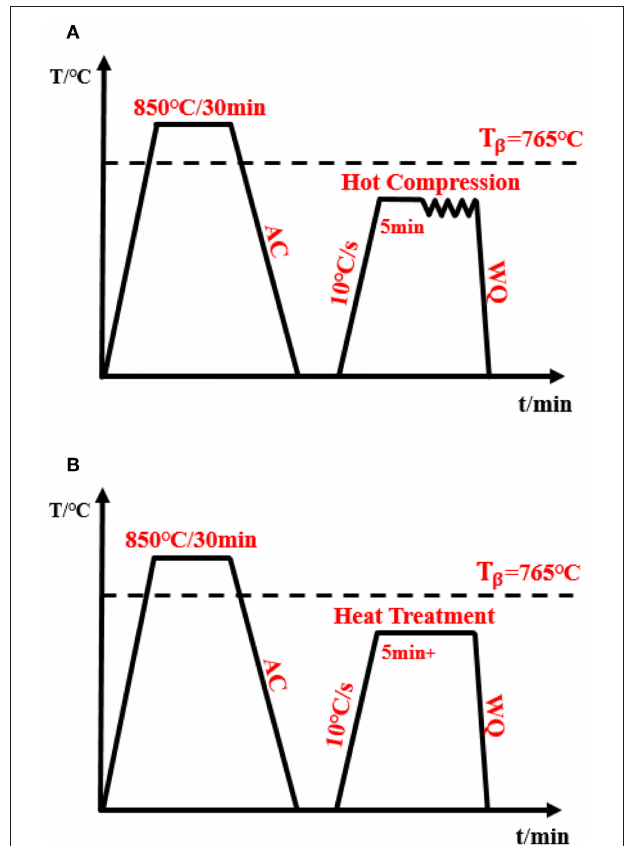
FIGURE 2 | Schematic illustration of specific parameters of (A) thermo-simulator compression test and (B) heat treatment.